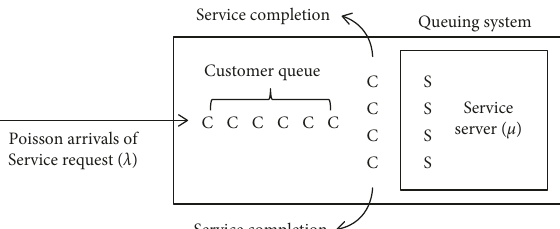
Figure 16: Multiserver queuing system (“C” represents a customer and “S” a server).